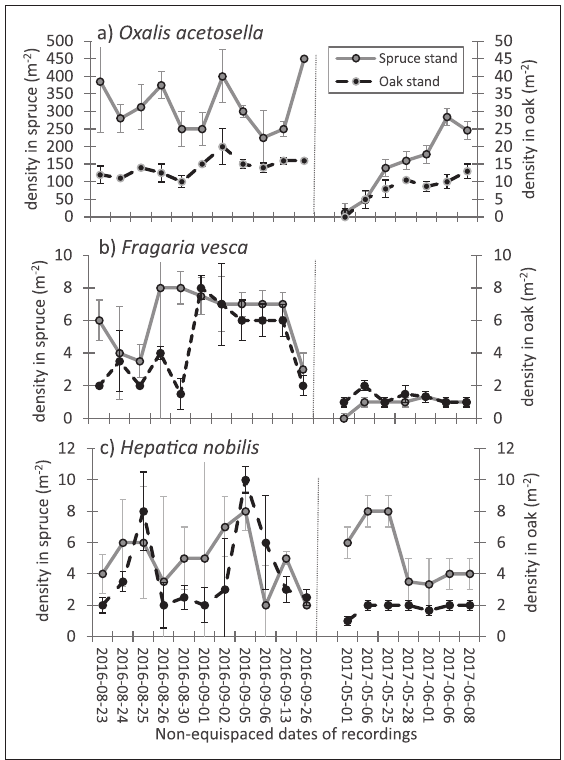
Figure 4 Plot showing a time series of changes in understorey plant cover of three common species, (a) Oxalis acetosella , (b) Hepatica nobilis , and (c) Fragaria vesca ), over one year in spruce and oak stand. Data are median ± 1 SE for each set of recordings. Non-equispaced dates of recordings are given on the x-axis, and a grey vertical dotted line marks the start of the winter period under snow when no recordings were possible. Note that Oxalis in the oak stand are plotted on a secondary axis at a far smaller scale for ease of comparison of the trends. Raw data given in the Supplemental Files 2 and 3.